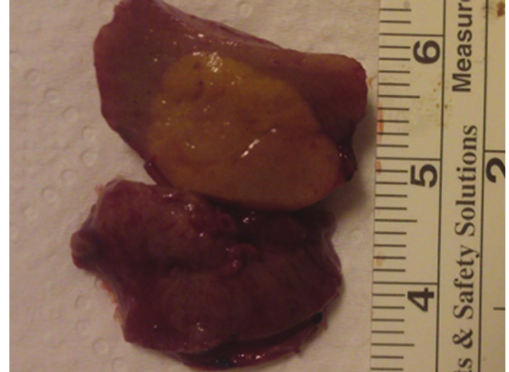
Figure 4: Macroscopic view of one of the tumors removed. The cut section appears light brown and glistering. No necrosis or hemorrhage is